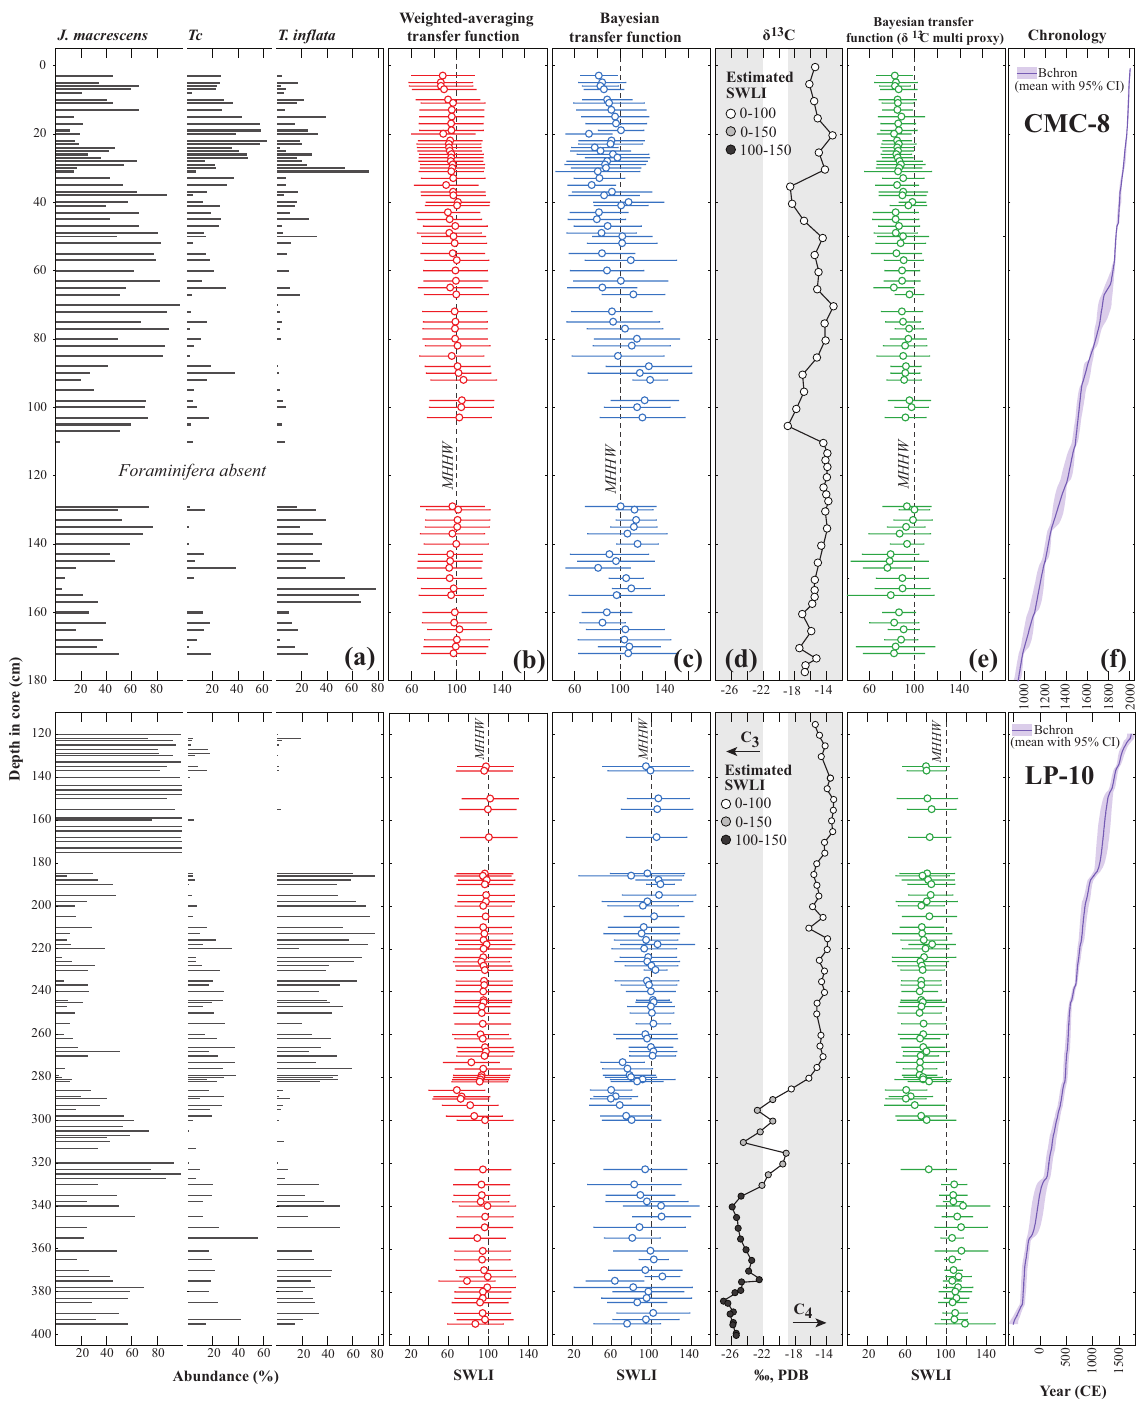
Figure 3. The abundance of the three most common species (Tc = Tiphotrocha comprimata ) of foraminifera found in cores from Cape May Courthouse (CMC-8) and Leeds Point (LP-10) are represented by the horizontal gray bars (a) . Paleo-marsh elevation, in standardized water level index (SWLI) units, was reconstructed using the weighted average transfer function (b) , the Bayesian transfer function (c) and the multi- proxy Bayesian transfer function (e) . Mid-points of the reconstruction are shown as white circles with the bars representing ± 2 σ uncertainty. Vertical dashed lines show the elevation of the mean higher high water (MHHW) tidal datum. Stable carbon isotope concentrations ( δ 13 C) for bulk sediment are parts per thousand (‰) relative to the Vienna Pee Dee Belemnite (VPDB) standard (d) . Bchron provided the chronology for both cores (f) . Note that some samples with counts of foraminifera lack a corresponding PME reconstruction because they lack a suitable modern analog using the criteria applied by Kemp et al.